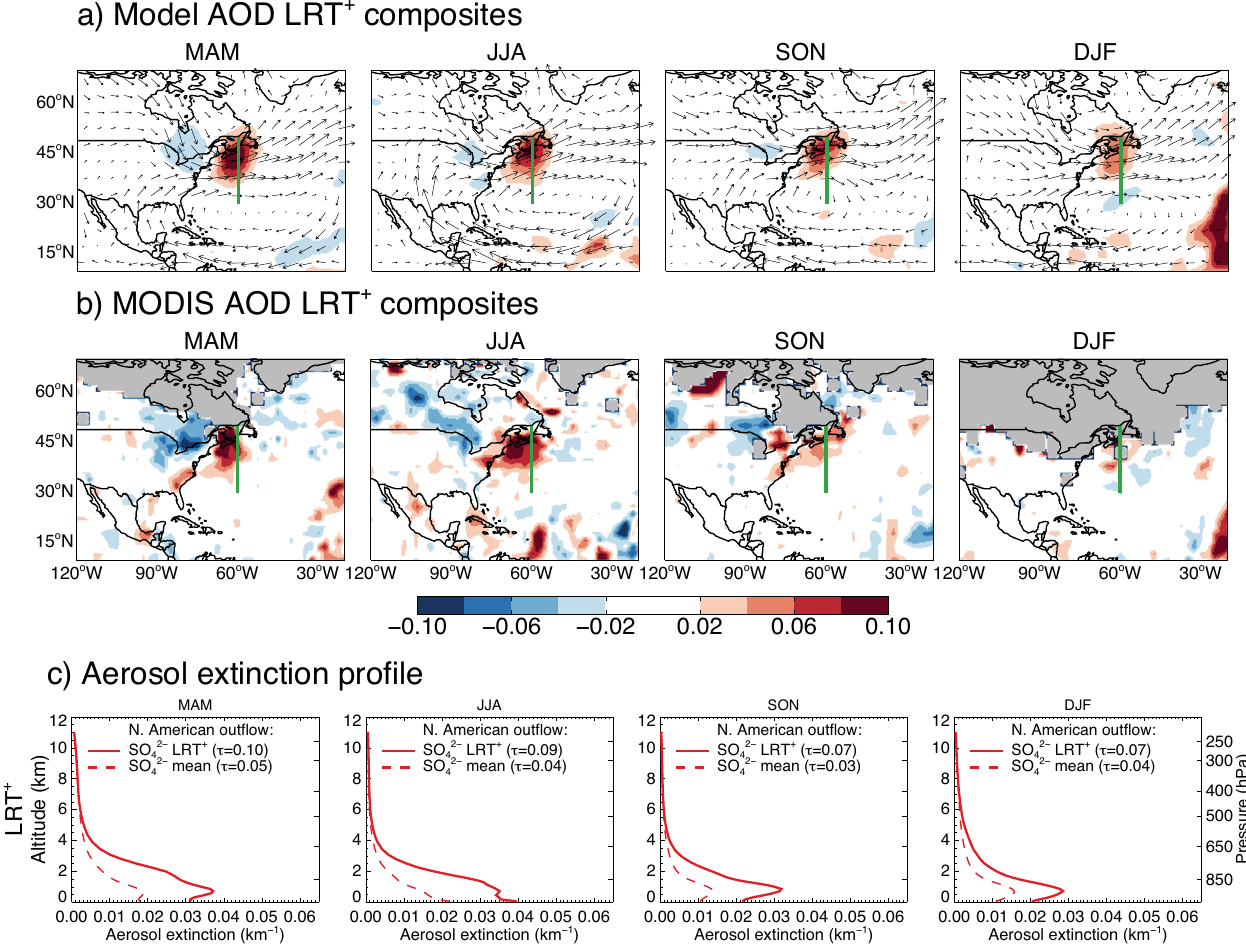
Fig. 8. Seasonal composites of AOD anomalies and extinction profiles over the NW Atlantic on LRT + days. (a) GEOS-Chem AOD anomalies (filled contours) with 850hPa wind fields (arrows). (b) MODIS AOD anomalies. (c) GEOS-Chem extinction profiles of sulfate aerosols at 60 ◦ W, 30 ◦ –50 ◦ N (location indicated by green line in panels (a) and (b) . The dashed lines indicate the seasonal average, while the solid lines correspond to mean profiles on LRT +